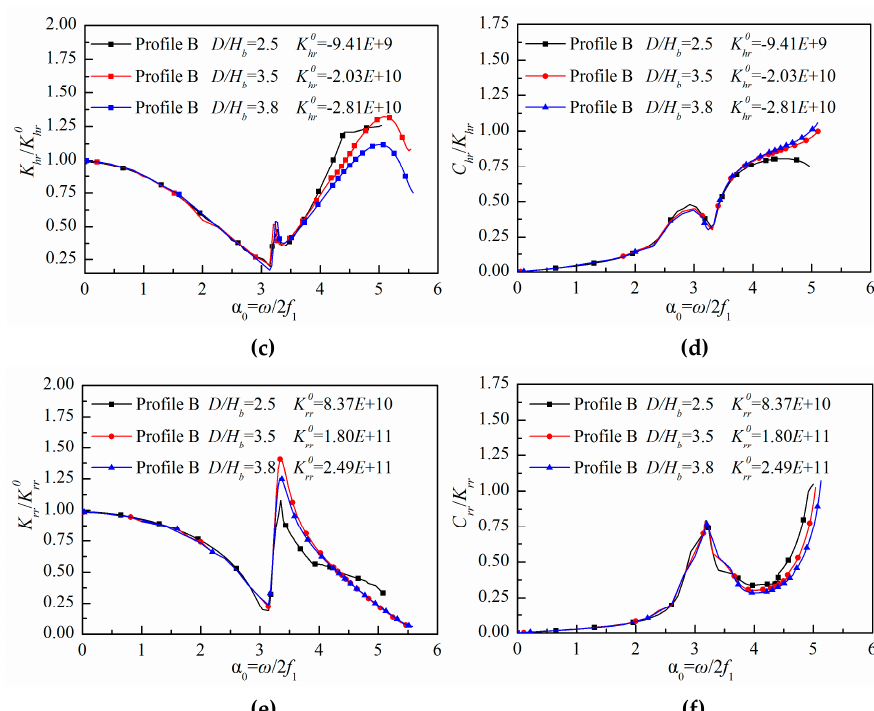
Figure 16. Variation of three dynamic impedance coefficients with respect to the dimensionless frequency under different diameter of WSBF embedded in Profile B: ( a ) Horizontal stiffness coefficient; ( b ) horizontal damping coefficient; ( c ) coupling stiffness coefficient; ( d ) coupling damping coefficient; ( e ) rocking stiffness coefficient; ( f ) rocking damping coefficient.